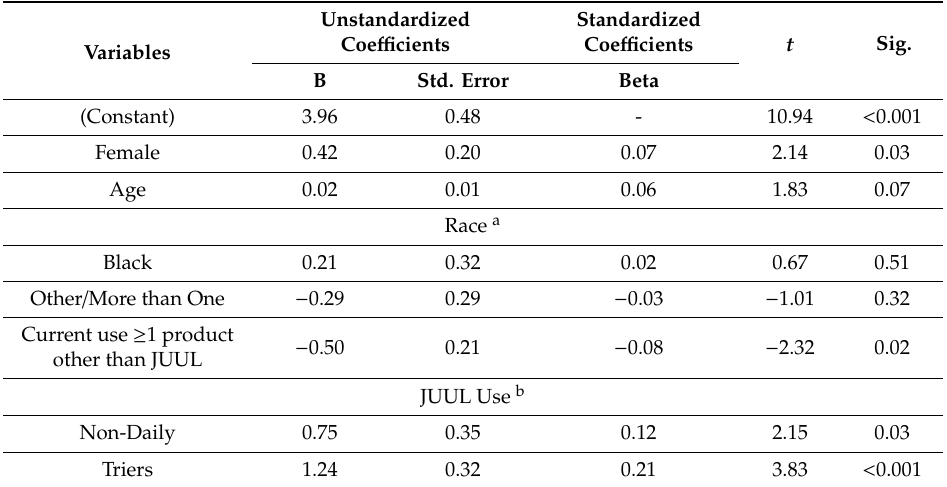
Table 3. Regression model of perceived harm of